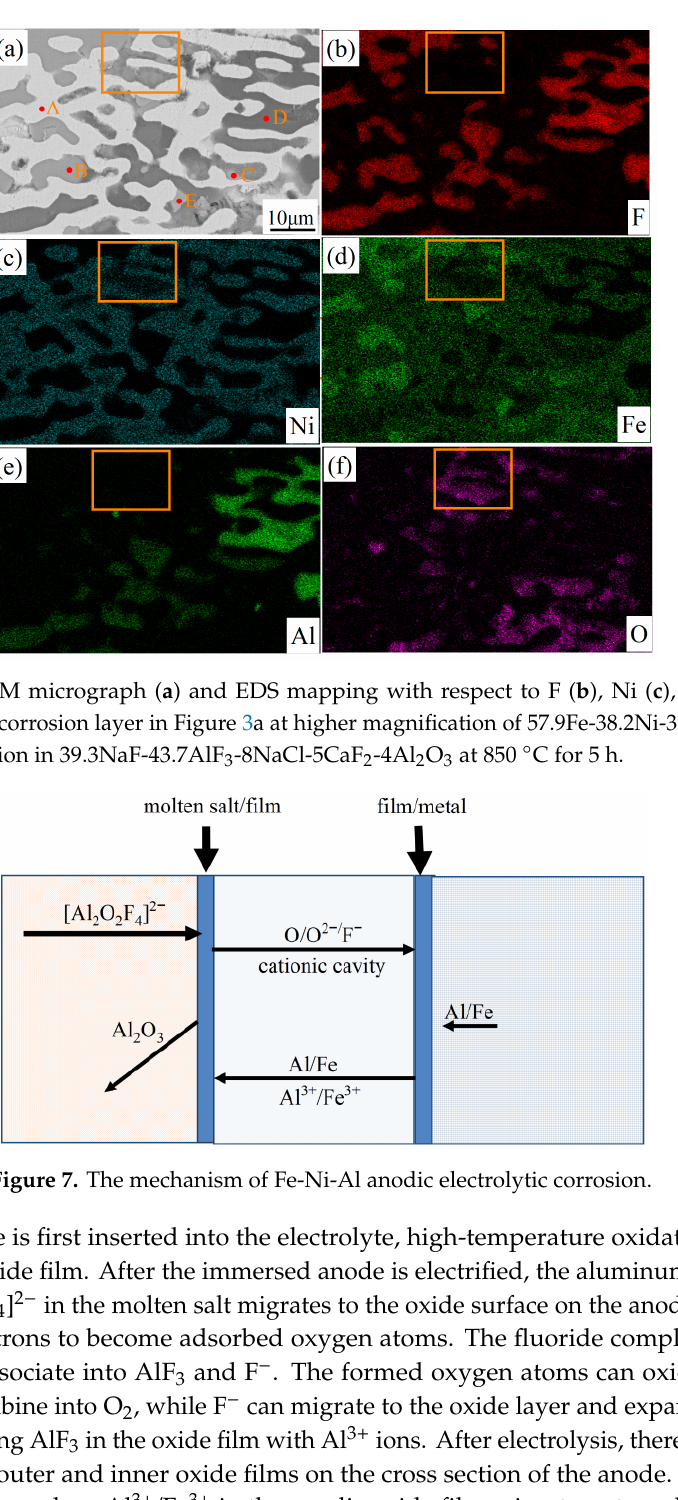
Figure 7. The mechanism of Fe-Ni-Al anodic electrolytic corrosion.